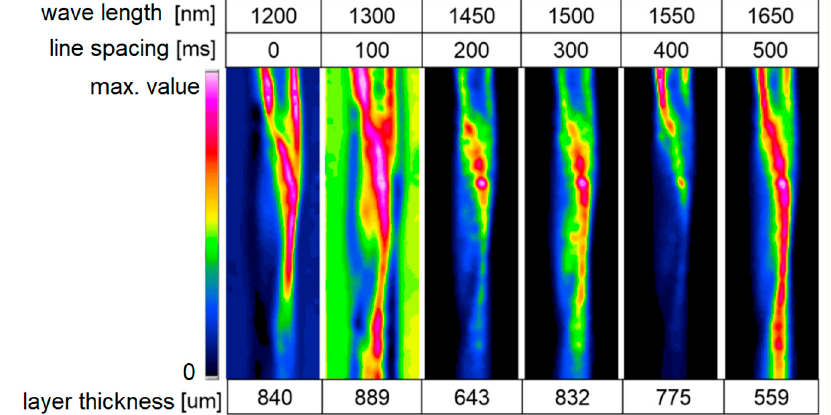
Figure 7. Near-infrared (NIR) measurement on water strands at all different wavelengths 274 × 142 mm (220 × 220 DPI), water glycerin [21].